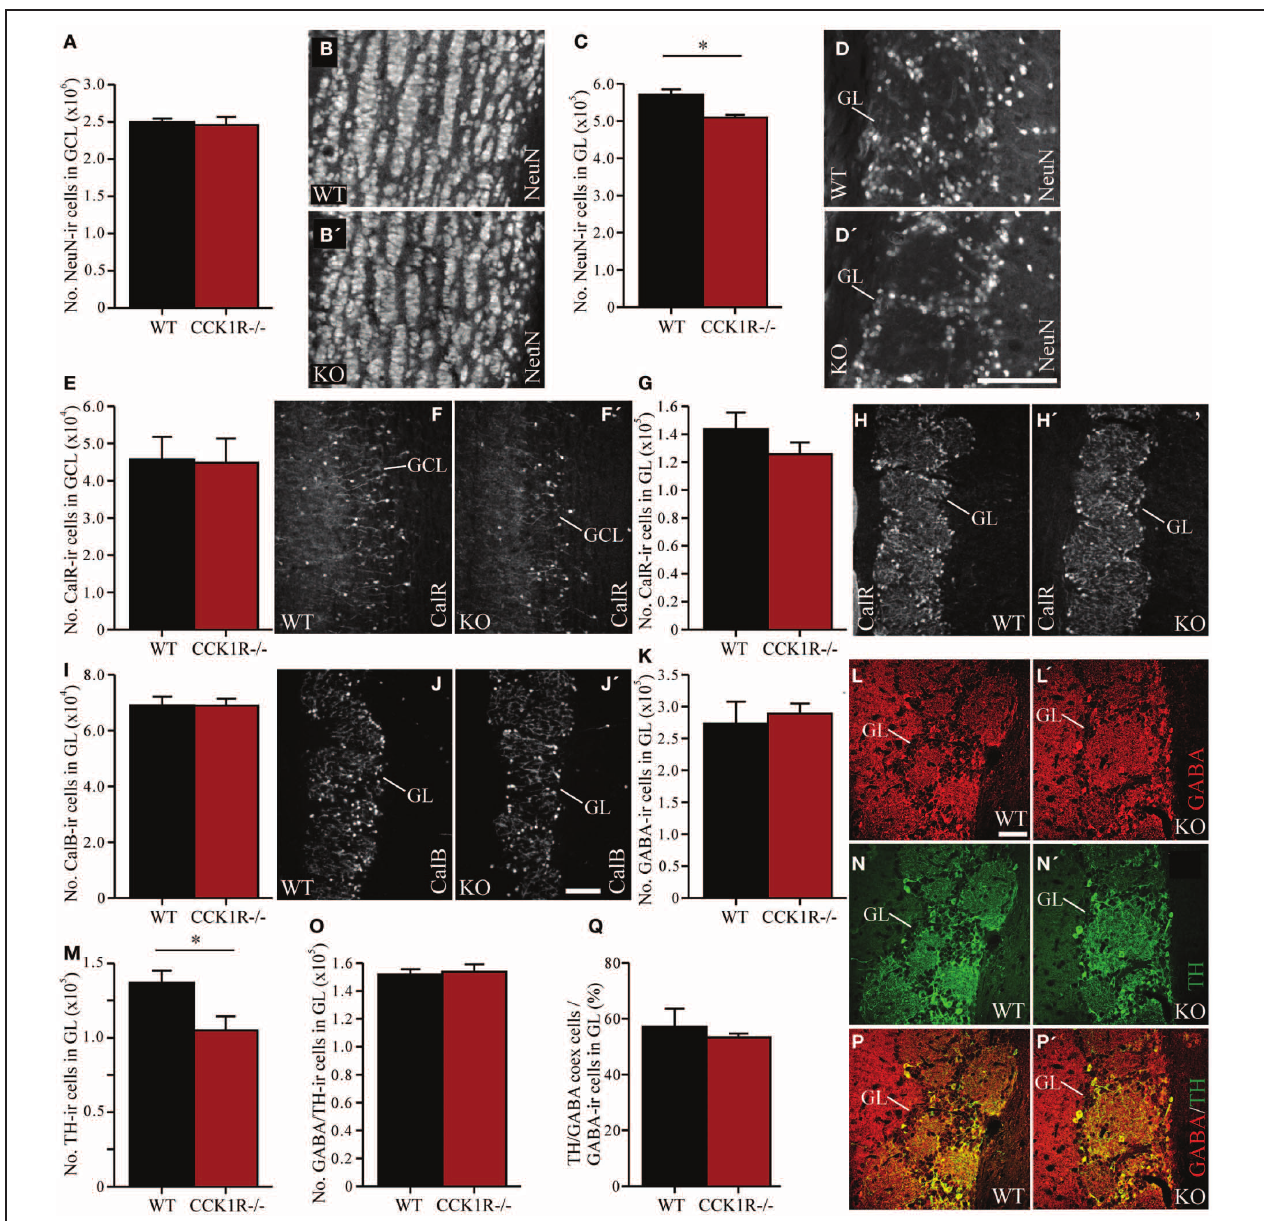
FIGURE 3 | The effect of reduced precursor proliferation in the SVZ of CCK1R − / − female mice on subclasses of interneurons in the GCL and GL. (A,B) Estimated number of NeuN-ir cell bodies in the GCL of wild-type and CCK1R − / − mice (A) . Photomicrographs of NeuN-LI in the GCL of (B) wild-type and (B (cid:3) ) CCK1R − / − mice. (C,D) Estimated number of NeuN-ir cell bodies in the GL of wild-type and CCK1R − / − mice (C) . Photomicrographs of NeuN-LI in the GL of (D) wild-type and (D (cid:3) ) CCK1R − / − mice. (E,F) Estimated number of calretinin-ir cell bodies in the GCL of wild-type and CCK1R − / − mice (E) . Photomicrographs of calretinin-LI in the GCL of (F) wild-type and (F (cid:3) ) CCK1R − / − mice. (G,H) Estimated number of calretinin-ir cell bodies in the GL of wild-type and CCK1R − / − mice (G) . Photomicrographs of calretinin-LI in the GL of (H) wild-type and (H (cid:3) ) CCK1R − / − mice. (I,J) Estimated number of calbindin-ir cell bodies in the GL of wild-type and CCK1R − / − mice (I) . Photomicrographs of calbindin-LI in the GL of (J) wild-type and (J (cid:3) ) CCK1R − / − mice. (K,L) Estimated number of GABA-ir cell bodies in the GL of wild-type and CCK1R − / − mice (K) . Photomicrographs of